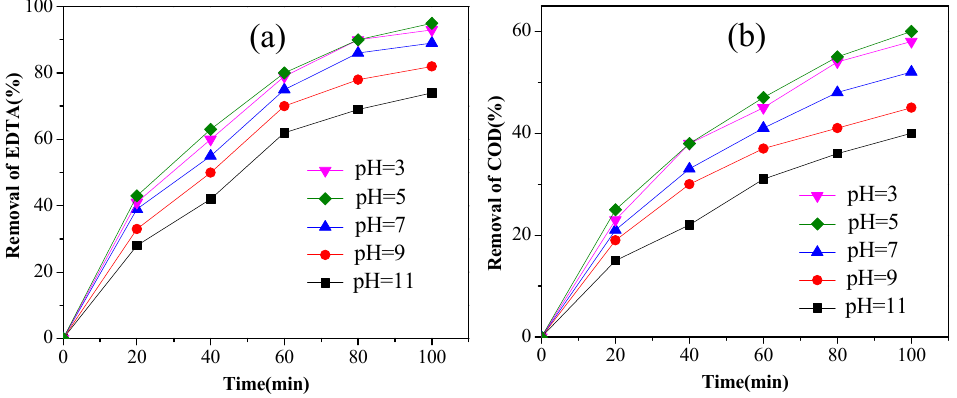
Figure 5. The effect of pH on the on EDTA removal ( a ) concentration; ( b ) COD (3% Pt/ACF electrode; EDTA concentration: 300 mg/L; electrolyte concentration: 0.1 mol/L; current density: 40 mA/cm 2 ).